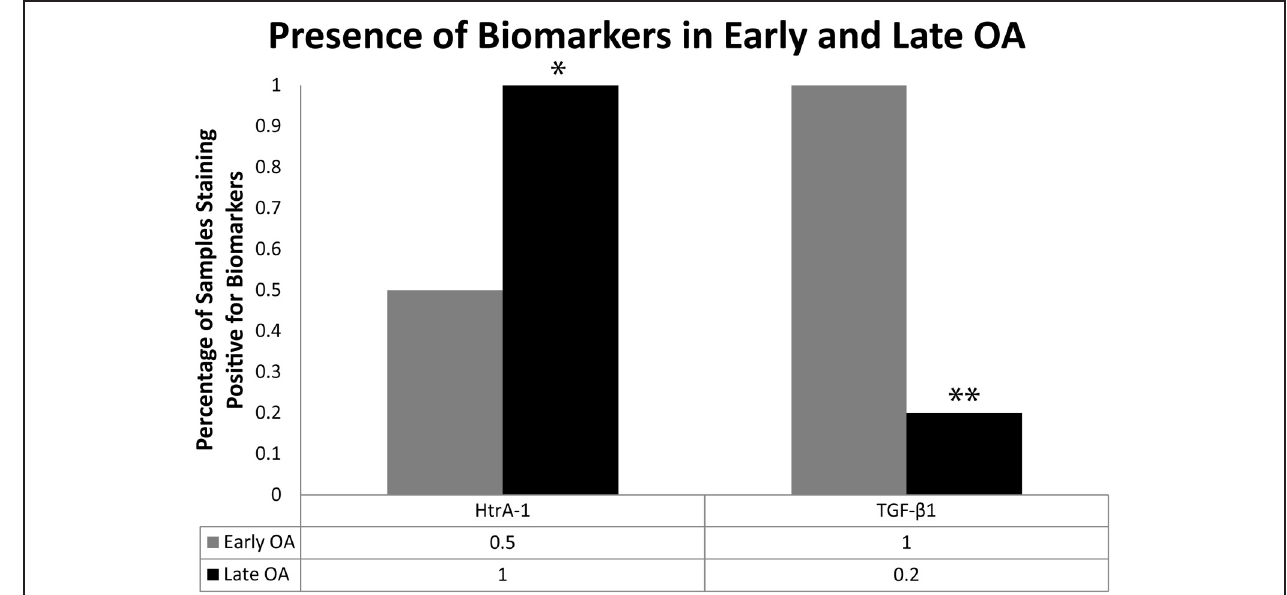
score > 4, n = 5) samples are shown here. The trend in frequency of positive staining was compared using a Chi-Squared test. Positive TGF- β 1 was observed at a high frequency in early OA samples, but at a significantly lower frequency in late OA samples ( ∗∗ p < 0 . 01). Conversely, the frequency of HtrA-1 was significantly higher in late OA samples than in early OA samples ( ∗ p < 0 .